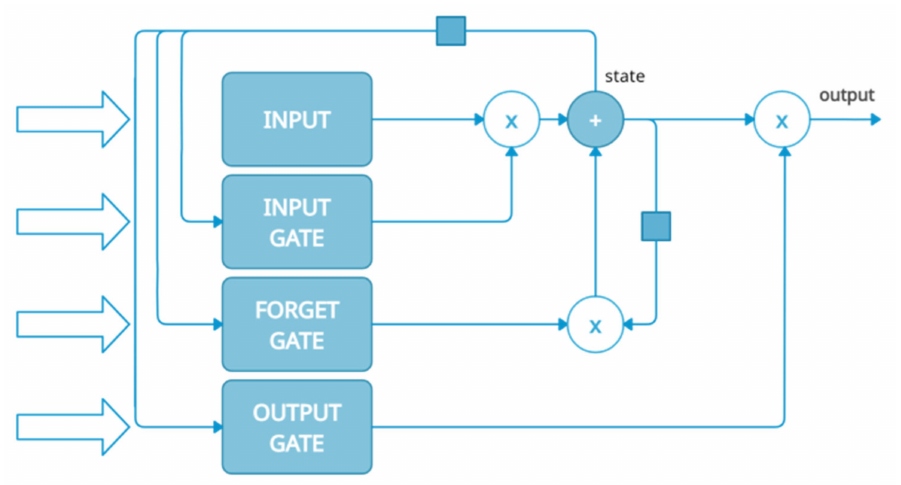
Figure 1. LSTM information processing